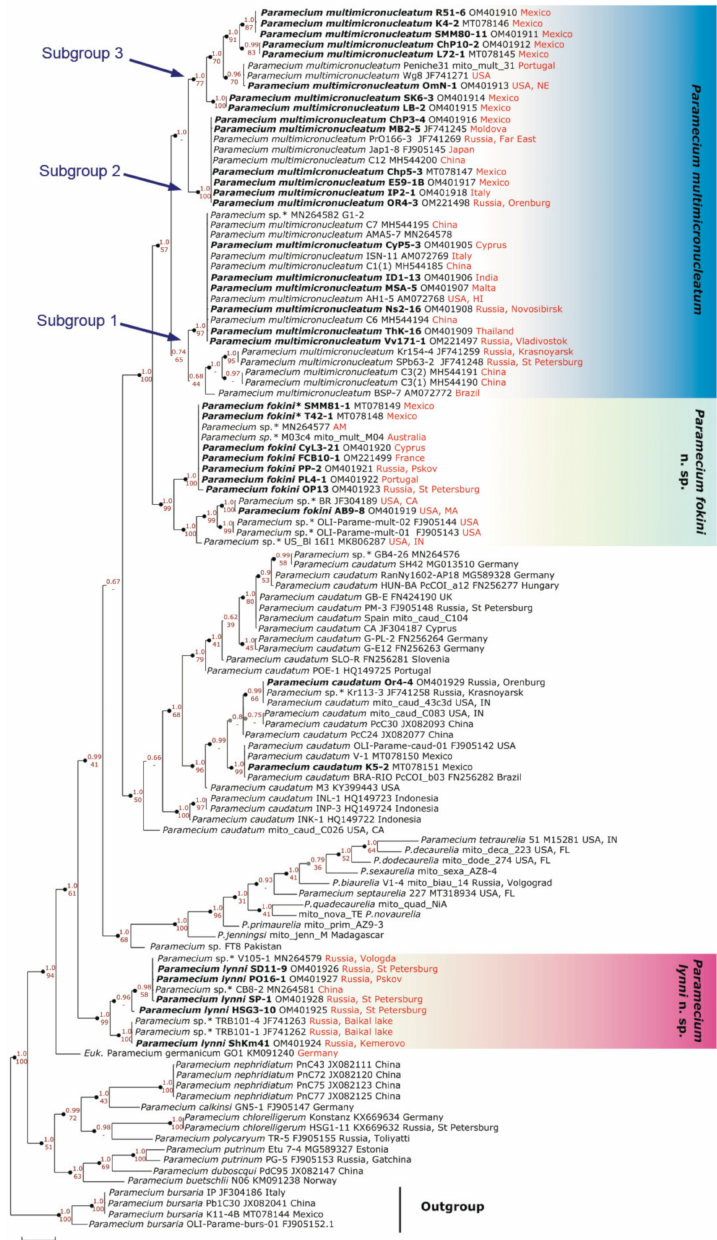
Figure 4. Phylogenetic position of three groups of Paramecium multimicronucleatum -like strains on the mitochondrial COI gene tree. Numbers associated with the nodes represent posterior probability from Bayesian inference (BI) and the bootstrap value from maximum likelihood (ML) analyses (only values of BI > 0.7 are shown). The symbol - indicates different architecture between ML and BI trees at the particular node. Strains marked in bold were analyzed in this study. Asterisks (*) indicate the misidentified or non-identified at the species level strains in NCBI (see Table S3). The arrows show three intraspecies subgroups within Paramecium multimicronucleatum